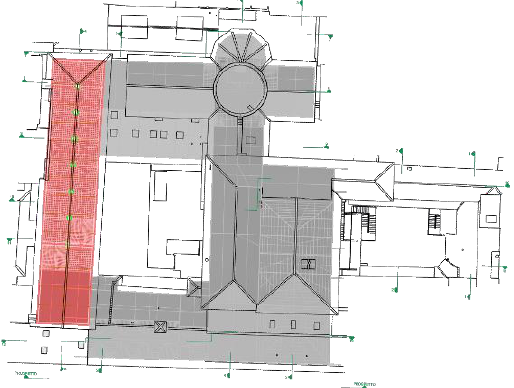
Figure 3. Superposition of the 3D FEM geometry in Rhinoceros® with the 2D drawing layer.